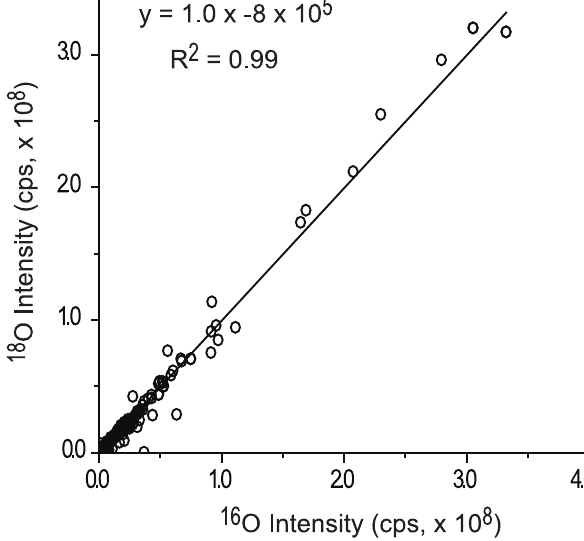
Figure 4. Plots compare the intensities of 16 O- and 18 O-labeled peptides. Linear regression analysis was performed on a total of 377 peptides. The equations and R 2 values for the regression line are shown.